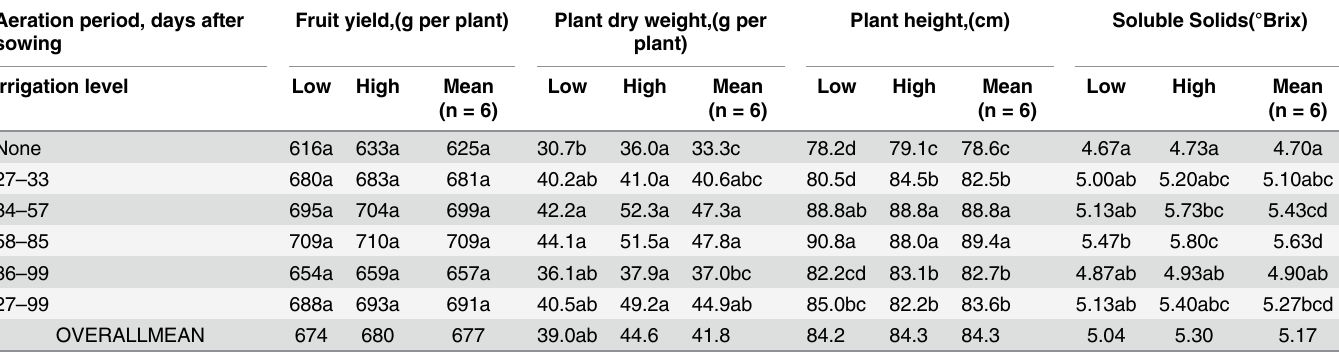
Table 1. Fruit yield, above-ground plant dry weight (g per plant), plant height (cm) and soluble solids content of the first ripe fruit from the first truss of potted single tomato plants for 6 post-infiltration aeration treatments (i.e. none or 2.5 liter aeration applied during 5 different periods) at 99 DAS. Pots were subsurface drip-irrigated at 2-day intervals to maintain the soil at 60 to 70% or 70 to 80% of volumetric field capacity (denoted as low and high irrigation level). Aeration period, days after